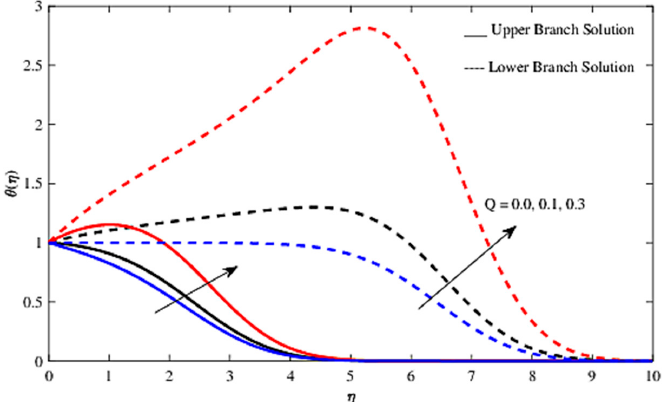
Figure 8. Temperature profiles θ ( η ) for several values of Q when λ = − 1.2, ε = 1000, M = 0.5 and Pr = 1.0.